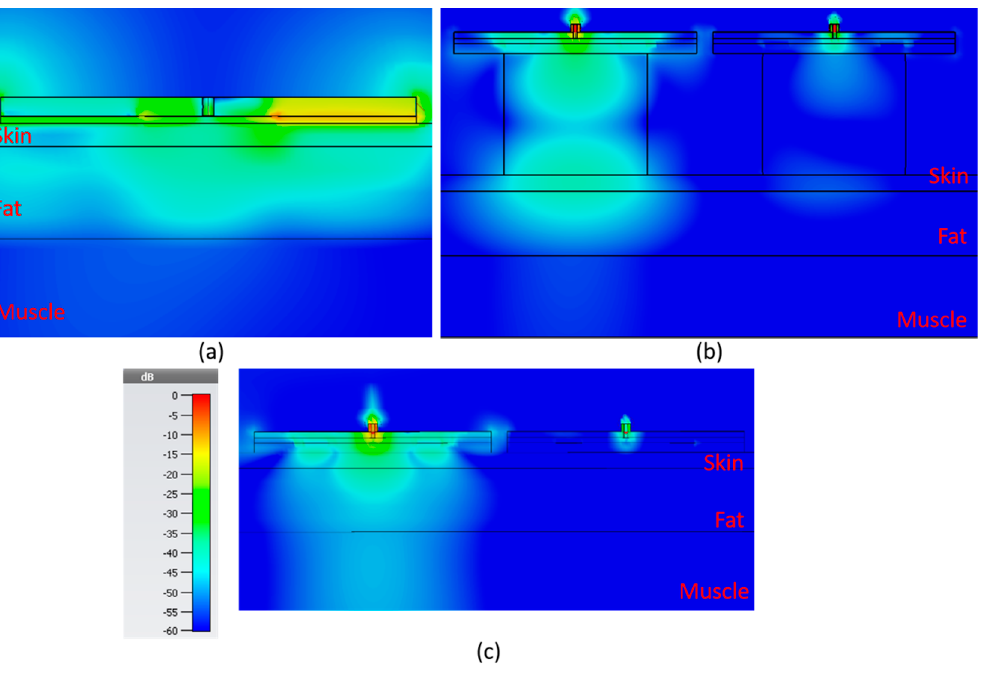
GHz and ( c ) SIW at 2.45 GHz. Color scale applies for all subfigures.